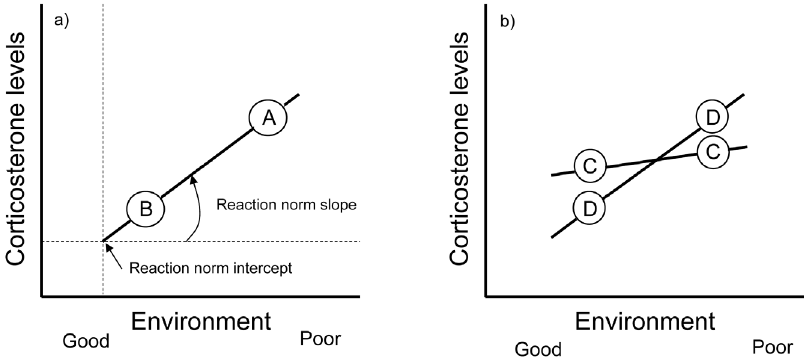
Figure 1. The concept of reaction norms. Reaction norms are the phenotypic expression of a single genotype across a range of environments. Reaction norms can be characterized by the intercept (e.g. initial hormone levels) and the slope of the line (e.g. stress responsiveness). Panel (A) depicts a hypothetical scenario, where there is only one reaction norm in the population (e.g. due to the lack of genetic variance or due to a strong selection for an optimal reaction norm). In this scenario, selection cannot act on hormone levels, because there is no variance between genotypes (individuals A and B have the same slope and intercept), i.e., all individuals will have identical hormone levels under the same environmental circumstances. However, without knowing the reaction norm, differences between the individuals (denoted by A and B) may be mistakenly attributed to results of natural selection on the hormone levels (if fitness is higher in the good environment than in the poor one). In panel (B), individuals differ in their reaction norms (both in the intercept and the slope). Different individuals (C and D) are sampled twice, once in a good environmental condition and once in a bad environmental condition. In this case, the between- and within-individual variation in hormone levels can be separated, and the reaction norm can be defined. If fitness related traits are also measured, then we can ask whether selection acts on the different reaction norms. In this special case, the reaction norms cross, making an individual by environment (I 6 E) interaction that has further consequences on how natural selection can act on the reaction norms in such a situation. See the text and references therein for further